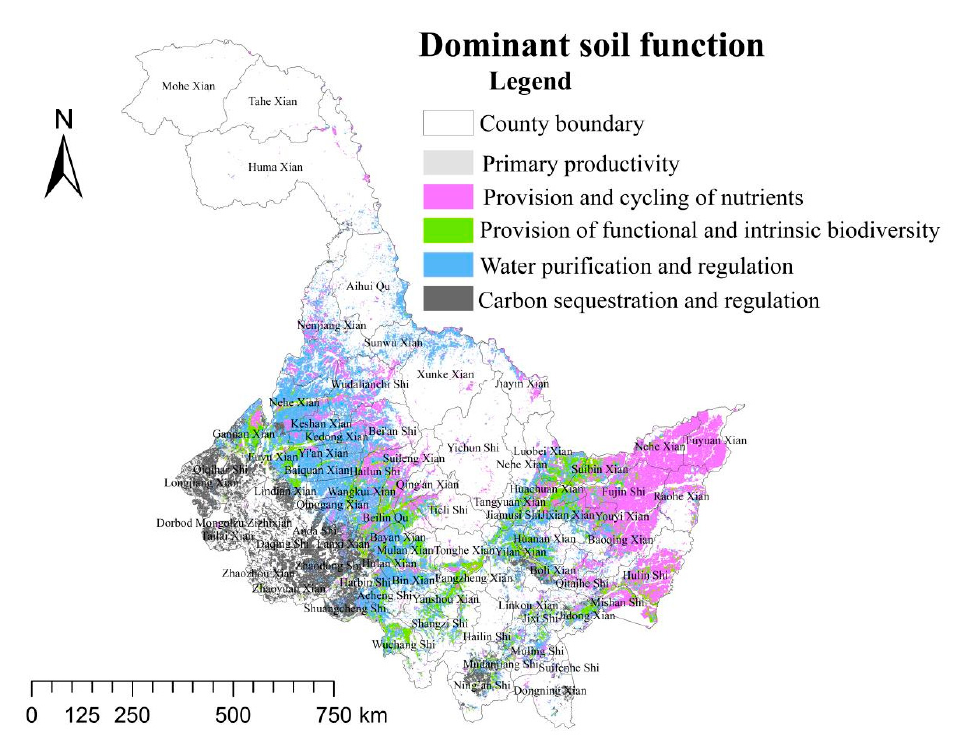
Figure 13. Dominant soil functions of cultivated land in Heilongjiang province.